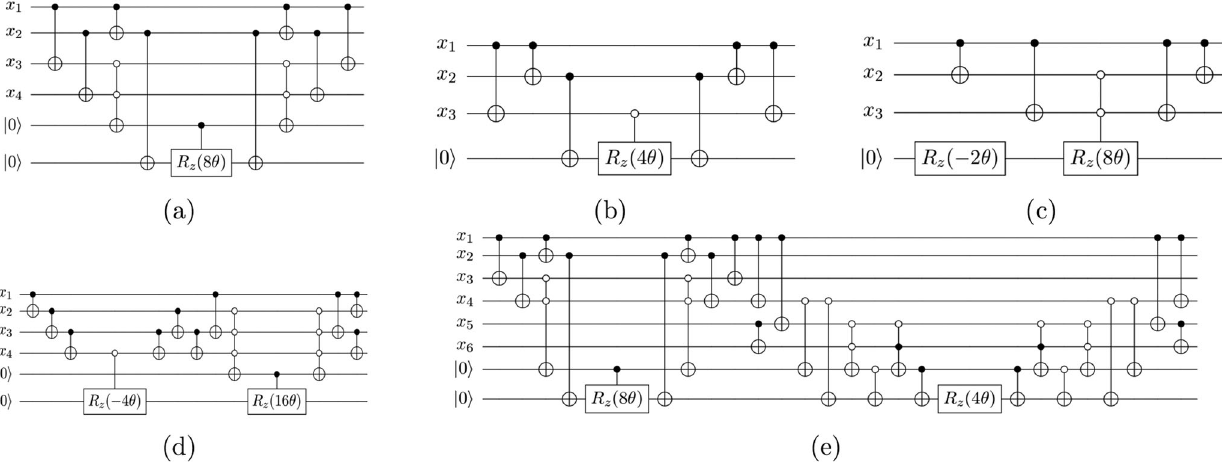
Fig. 6 Quantum circuit simulating e it θ